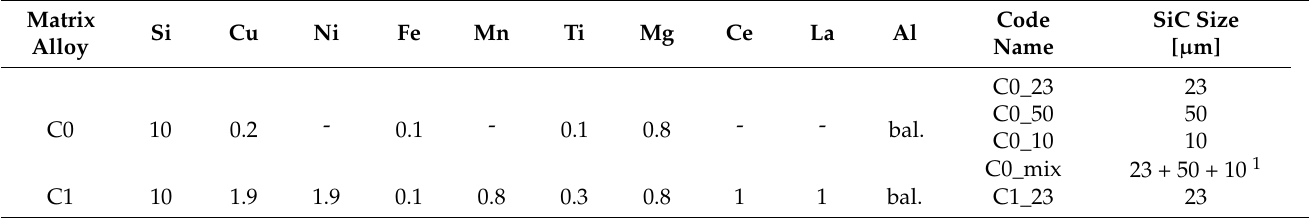
Table 2. Chemical composition [wt.%] of the composite materials and the weight fraction of